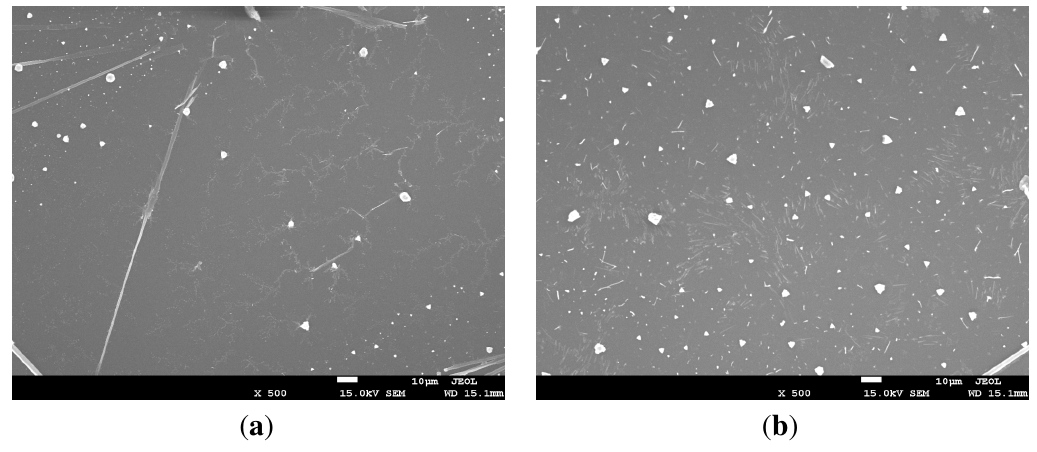
Figure 10. Resistance vs. temperature at different protein concentrations and the cytochrome c thin film resistance at different concentrations. Zero concentration of protein means that only the buffer solution was applied on the SU-8 photoresist